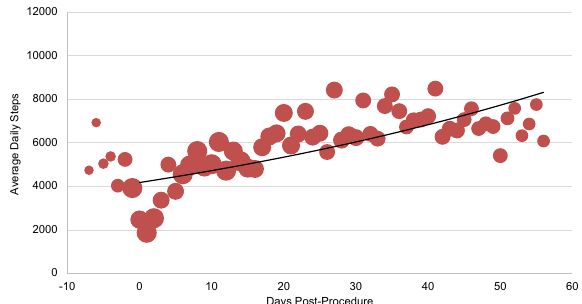
Fig. 3 Average steps per day for patients who underwent atrial fi brillation ablation ( n = 30). Bubble size corresponds to number of patients for whom data were synced. Procedure occurred on day 0. Negative days indicate pre-procedure data, when available. Data obtained via Fitbit Charge 2 TM